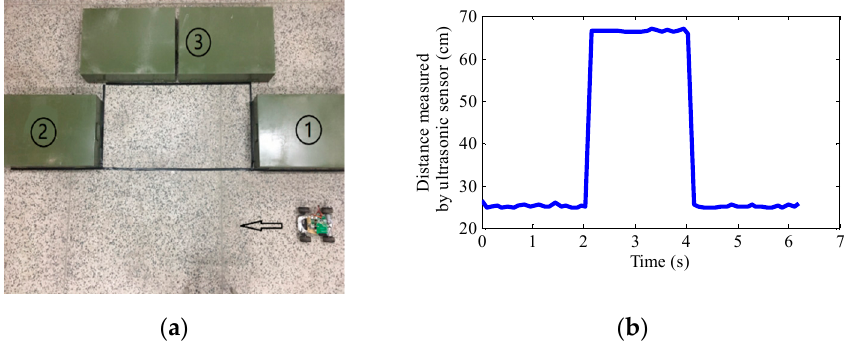
Figure 9. Parking space detection experiment for parallel parking: ( a ) Experiment scene; ( b ) Experimental results of a parking space detection.